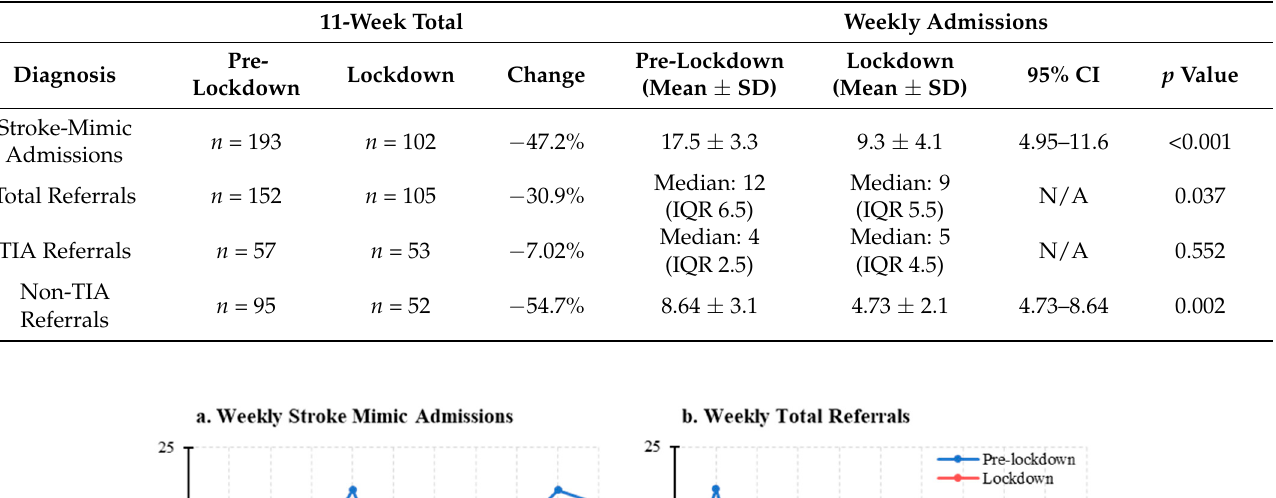
Table 4. Stroke Mimic Admissions and TIA Referrals in the Pre-lockdown and Lockdown Cohorts. Stroke mimic/non-stroke admissions as well as TIA referrals in the pre-lockdown and lockdown cohorts. A highly significant reduction in weekly stroke mimic admissions was noted in the lockdown cohort. There were significantly fewer weekly referrals made in the lockdown cohort; the number of referrals diagnosed as TIA remained similar, with a significant reduction in referrals deemed to be non-TIA. p values were generated with Student’s t-test if data were normally distributed, otherwise Wilcoxon’s signed-rank was performed; values <0.05 were deemed statistically significant. TIA: transient ischaemic attack, SD: standard deviation, IQR: interquartile range, CI: confidence intervals, NA: not available.